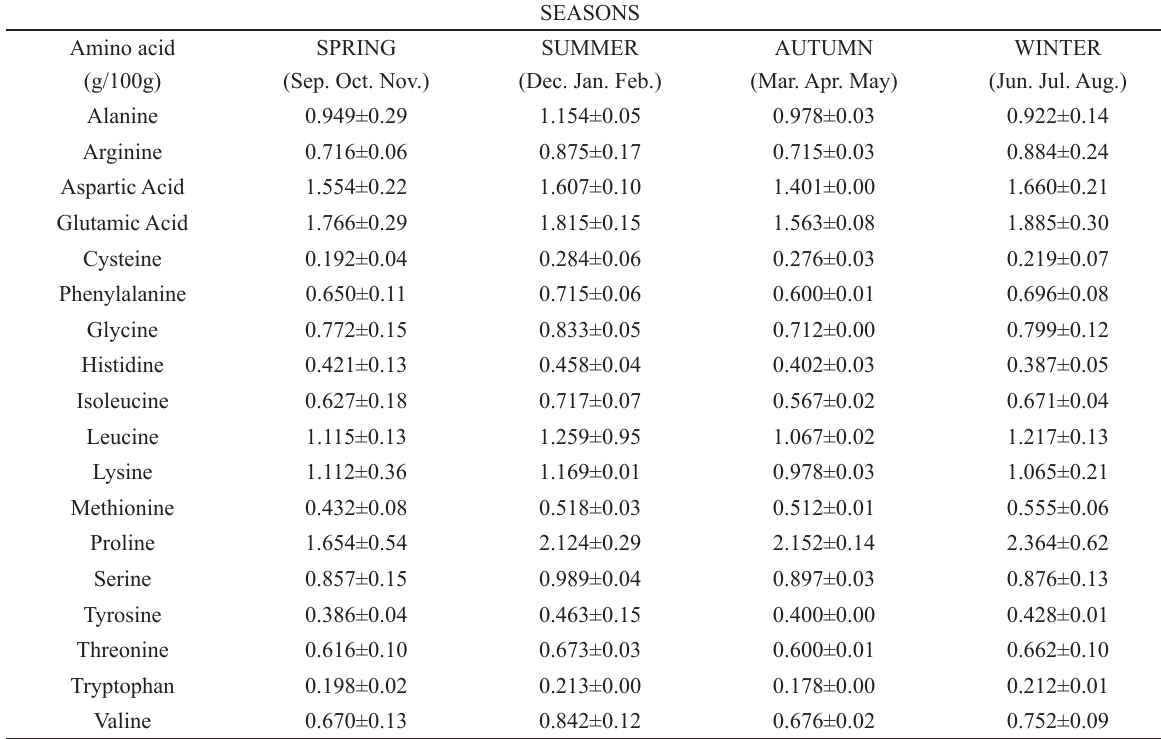
Chemical composition of bee pollen collected by Apis mellifera in different seasons.